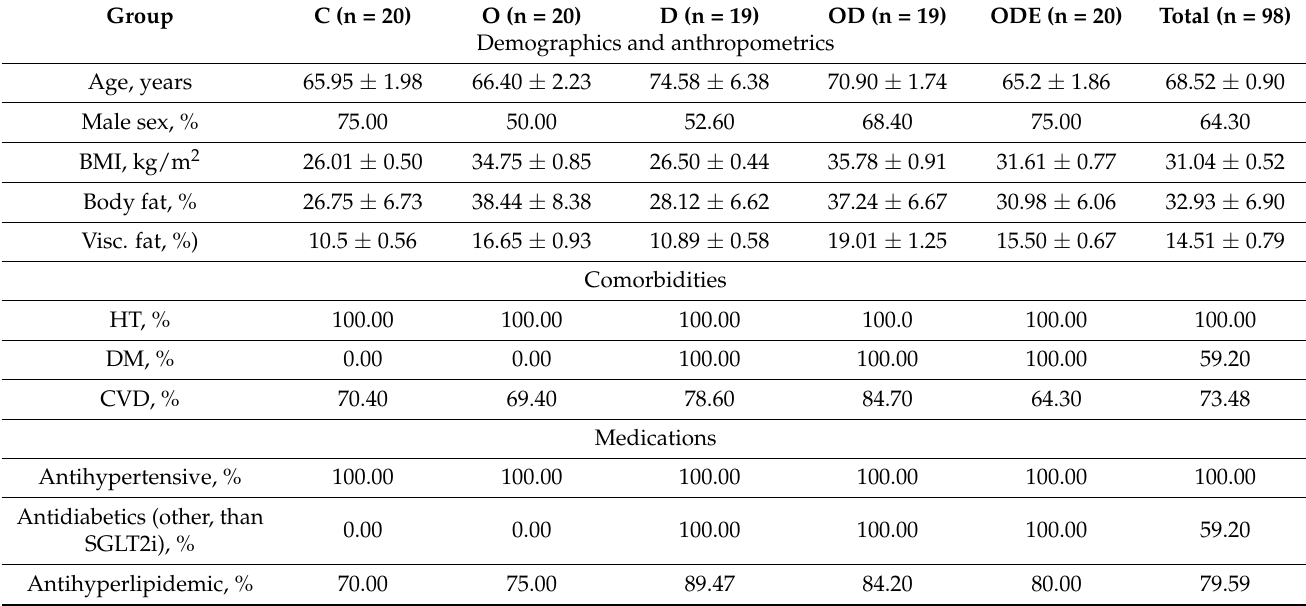
Table 1. Patients’ general characteristics, n = number of patients, BMI = body mass index, kg =